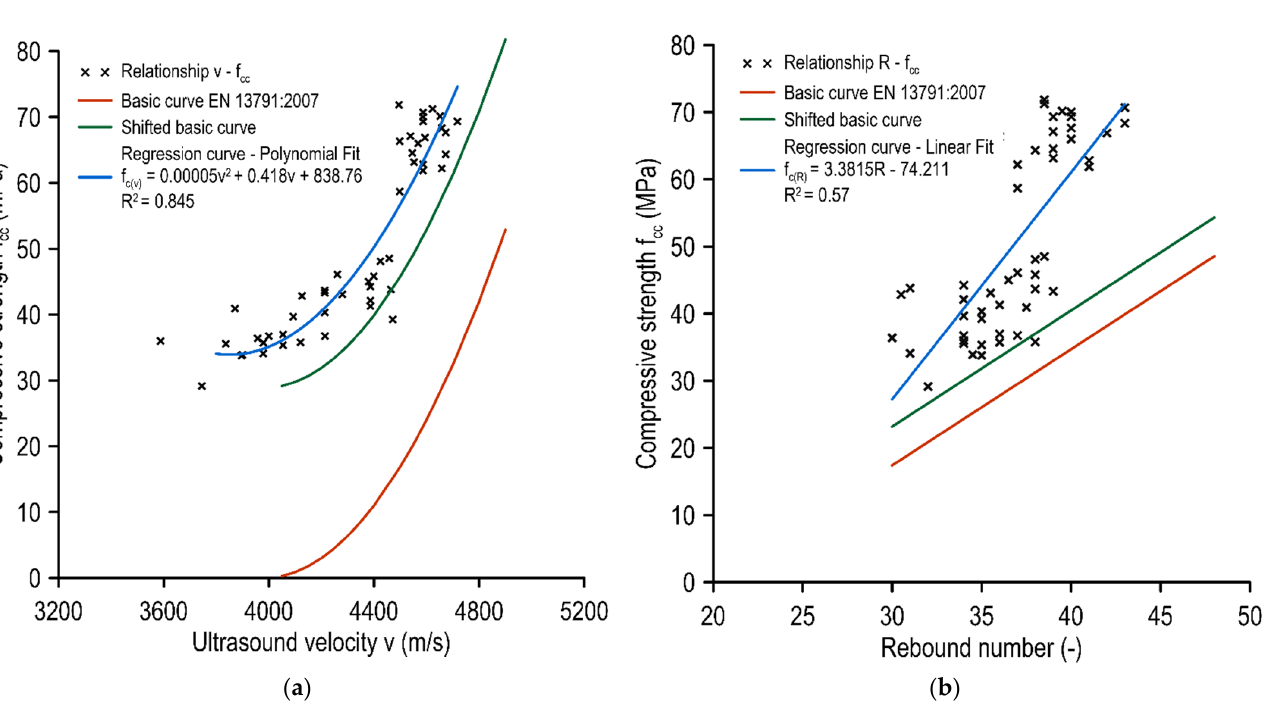
Figure 10. A comparison of non-destructive tests results to the compressive strength with normative basic curves: ( a ) ultrasound vs. compressive strength test results and ( b ) sclerometric vs. compressive strength test results.